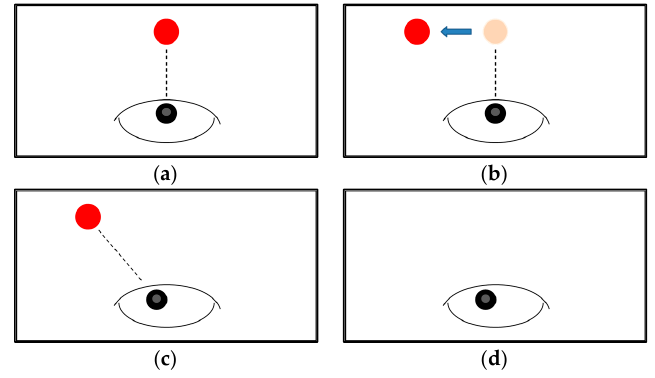
Figure 12. Procedure for command set for performance evaluation. ( a ) Look at the center circle and has a bite action; ( b ) Change the circle position after two seconds. ( c ) Move your eyeball to gazing the circle ( d ) reset by release of biting force.